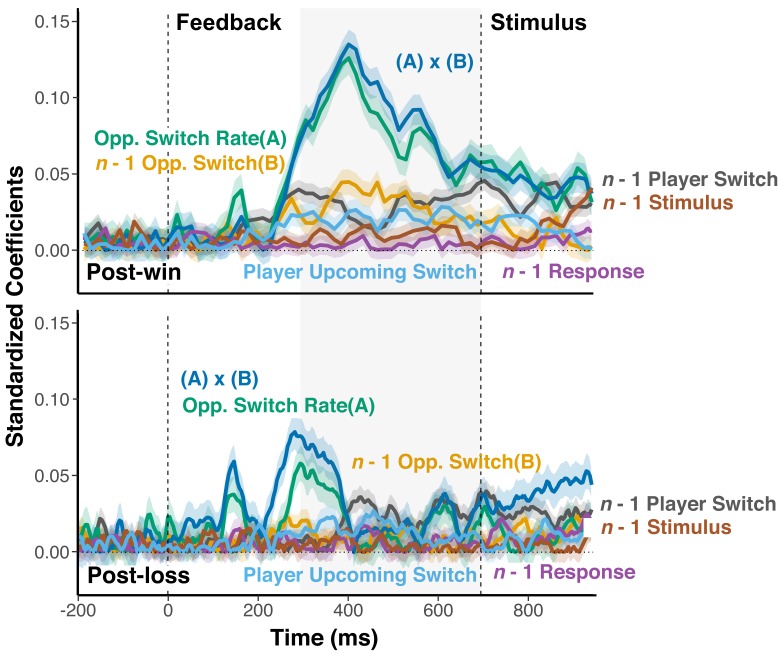
Controlling for Upcoming Switch and n-1 Stimulus/Response Positions.The supplement shows the results of the same analysis as in Figure 5, but adding potentially relevant control variables. It is possible that the feedback-related differences for the history/context coefficients shown in Figure 5 are due to the fact that feedback affects the probability of an upcoming switch. For example, the EEG effects may reflect preparatory processes associated with an upcoming switch, such as the allocation of effort. As shown, information about the upcoming switch/no-switch choice was reliably reflected in the EEG signal (t = 2.67). However, different from the history/context variables, the coefficient associated with the upcoming choice was not affected by post-win/-loss feedback (t = 0.68). This pattern is consistent with (Donahue et al., 2013) who have found that frontal and parietal neurons code past choices in a feedback-contingent manner, but represent the upcoming choice in a manner that is not conditioned on previous-trial feedback. As additional control analyses, we also added n-1 stimulus position and response locations to ensure that none of the effects of interest are driven by such lower-level effects. As evident, the overall pattern of history/context effects remains the same when controlling these potential influences.